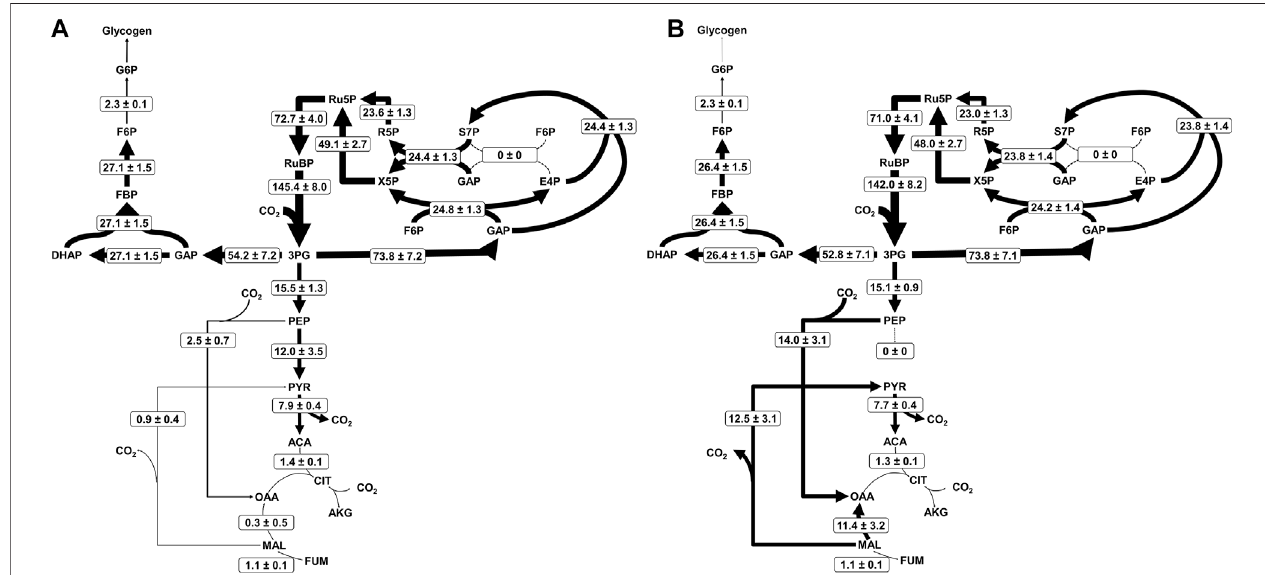
FIGURE2 | Metabolic fl ux maps for Synechococcus 7002 (A) WT and (B) LS. Net fl uxes areshown in theform M ± SEwhere M isthe calculated fl ux and SEis the standarderrorofthe95%con fi denceinterval,calculatedusingupperandlower fl uxboundsfromparametercontinuationanalysis.Arrowthicknessisproportionaltothe logarithmofthe fl ux throughthe givenreaction,and dotted lines indicate nosigni fi cant fl ux. Flux valuesfor everyreaction inthe network, upper andlower bounds oftheir respective 95% con fi dence intervals, and dilution parameters are listed in Supplementary Table S4 .